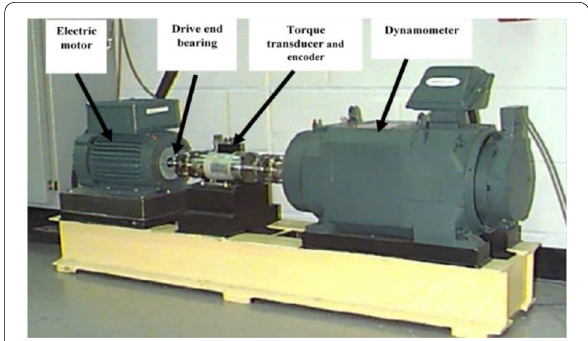
Figure 11 Test rig used to collect the first vibration data of bearings (CWRU Bearing Data